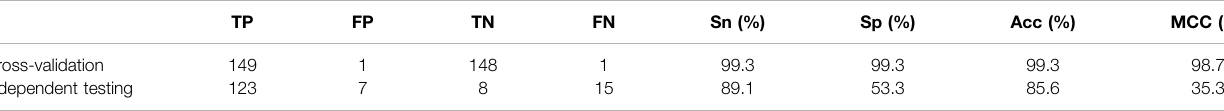
TABLE 5 | Performance of the LADTree model in the second-layer.